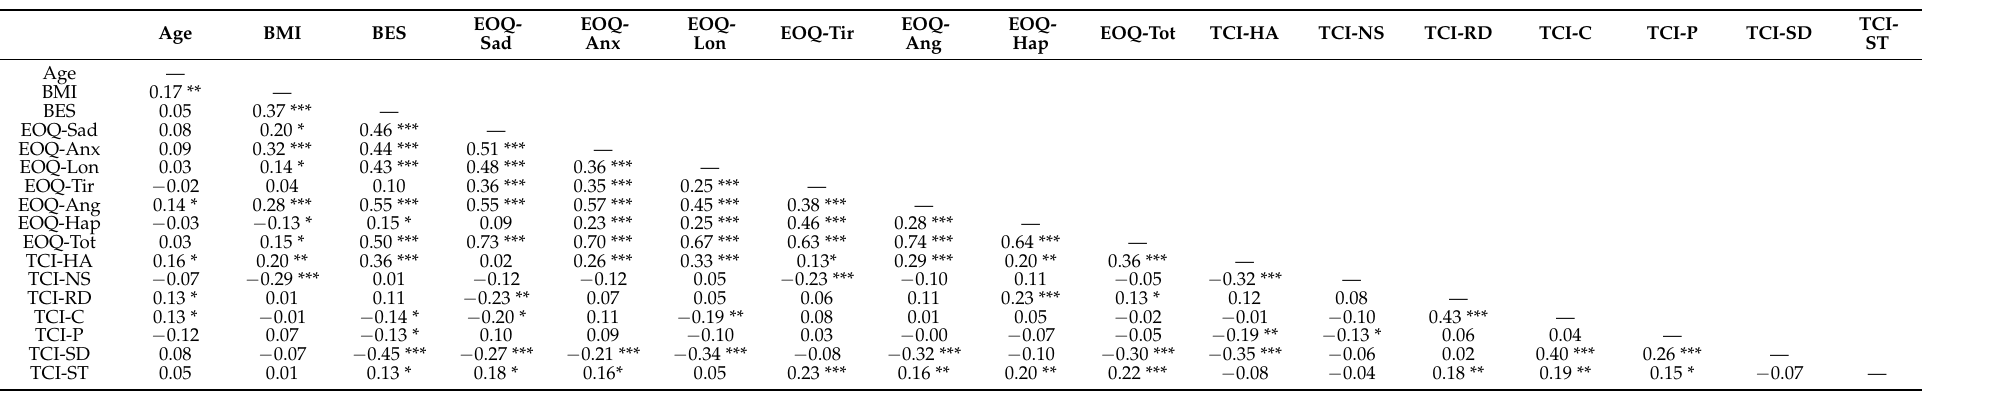
Table 3. Correlation